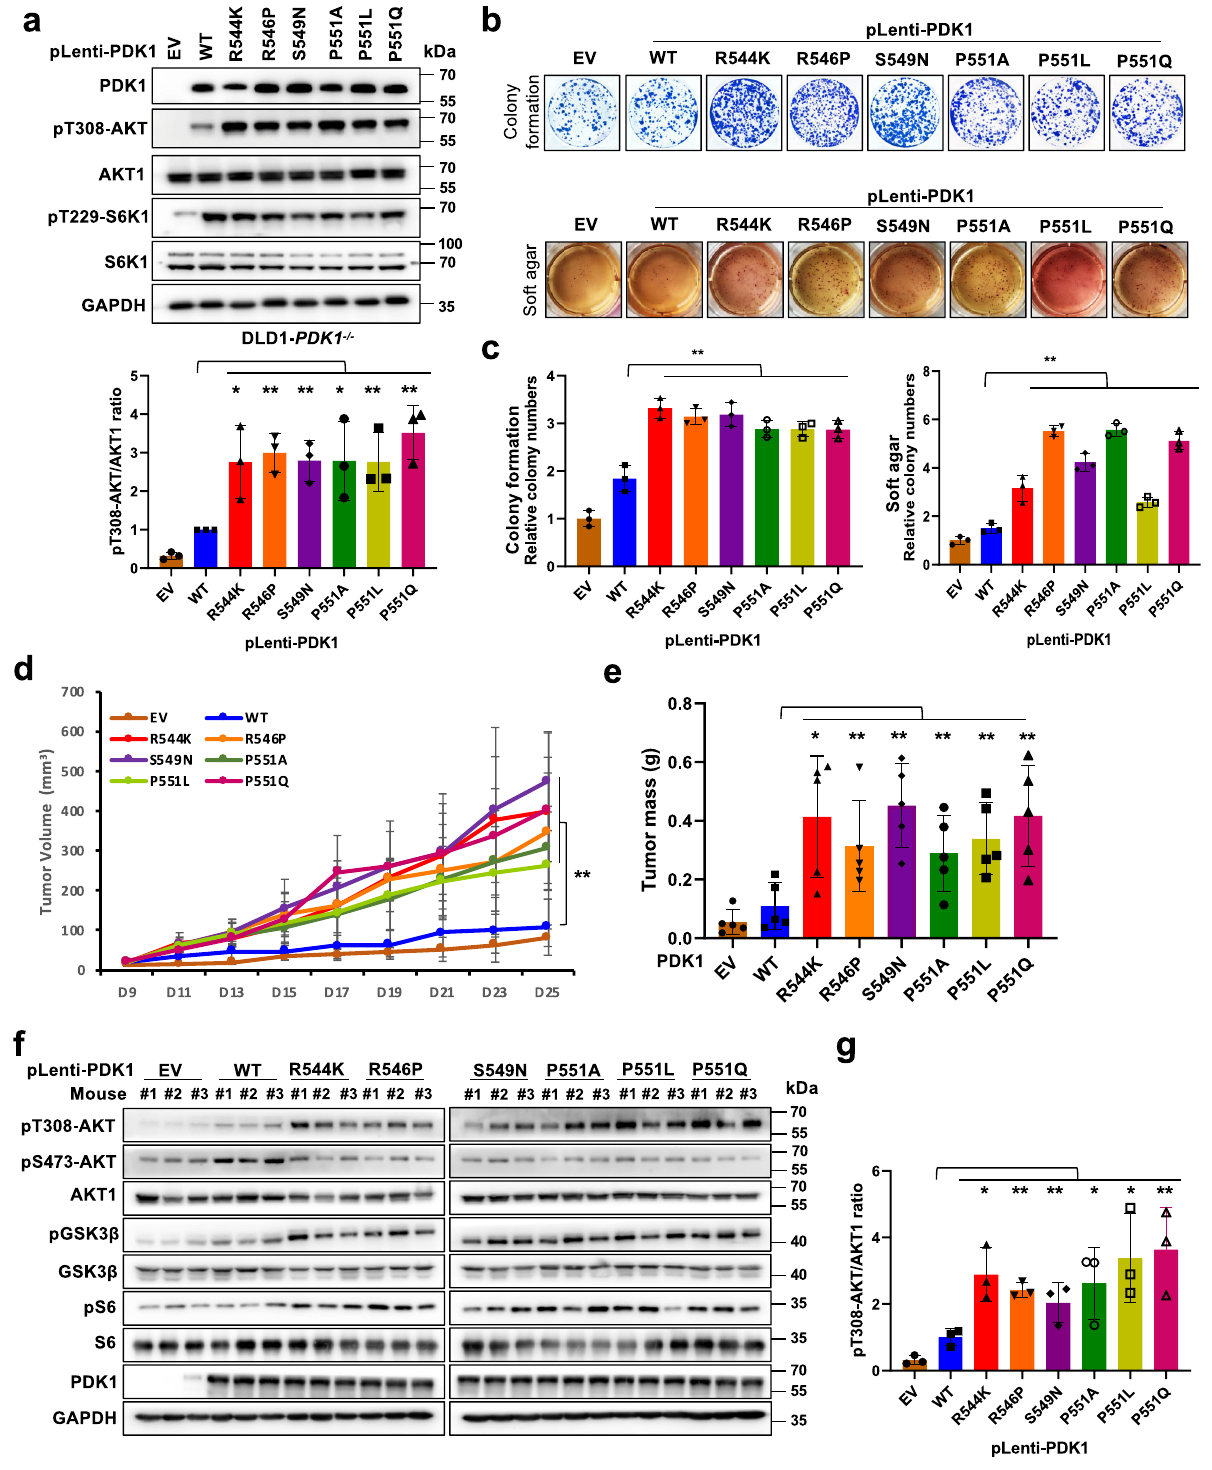
Fig. 6 Patient-derived mutations of PDK1 promote AKT1 activation and oncogenic functions. a IB analysis of DLD1- PDK1 knockout cells stably infected with the indicated constructs. pT308-AKT/AKT1 ratio were calculated. (mean ± SD, n = 3), * P < 0.05, ** P < 0.01. b , c Cells generated in a were subjected to colony formation and soft agar assays. (mean ± SD, n = 3) ** P < 0.01. d , e Cells generated in a were subjected to mouse xenograft assays. Tumor sizes were monitored ( d , P = 0.0045), and dissected tumors were weighed ( e , P = 0.013, 0.008, 0.002, 0.003, 0.0003, 0.003). The Error bars in the d , e are mean plus or minus SD, n = 5 mice. * P < 0.05, ** P < 0.01. f IB analysis of WCL derived from dissected tumor tissues. g pT308-AKT/AKT1 ratio in f were calculated, (mean ± SD, n = 3), * P < 0.05, ** P < 0.01. Statistical signi fi cance was determined by two-tailed Student ’ s t -test in a , c , e , g and two-way ANOVA in d . * P < 0.05, ** P < 0.01. Source da t a are provided in Source Data fi les. EV, empty vector. WCL, whole cell lysate. WT, wild type.